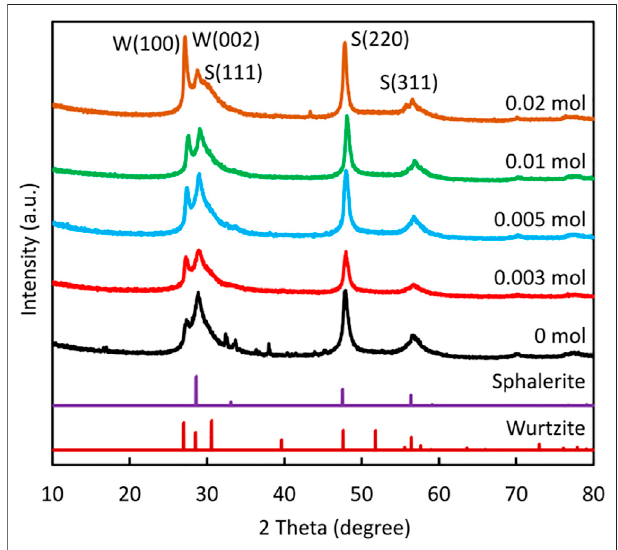
FIGURE 1 | XRD patterns of ZnS prepared using different amounts of